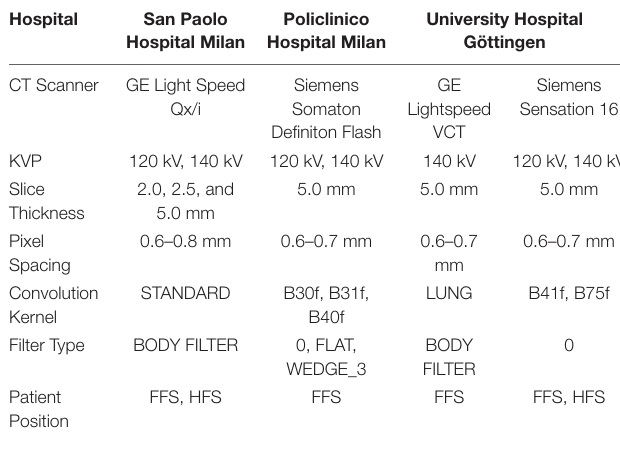
TABLE 2 | Technical characteristics of the CT scanner